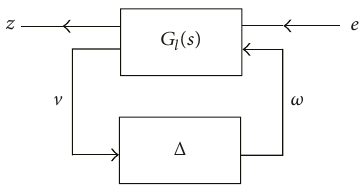
Figure 2: The feedback system model structure. Figure 3: The transferred system model